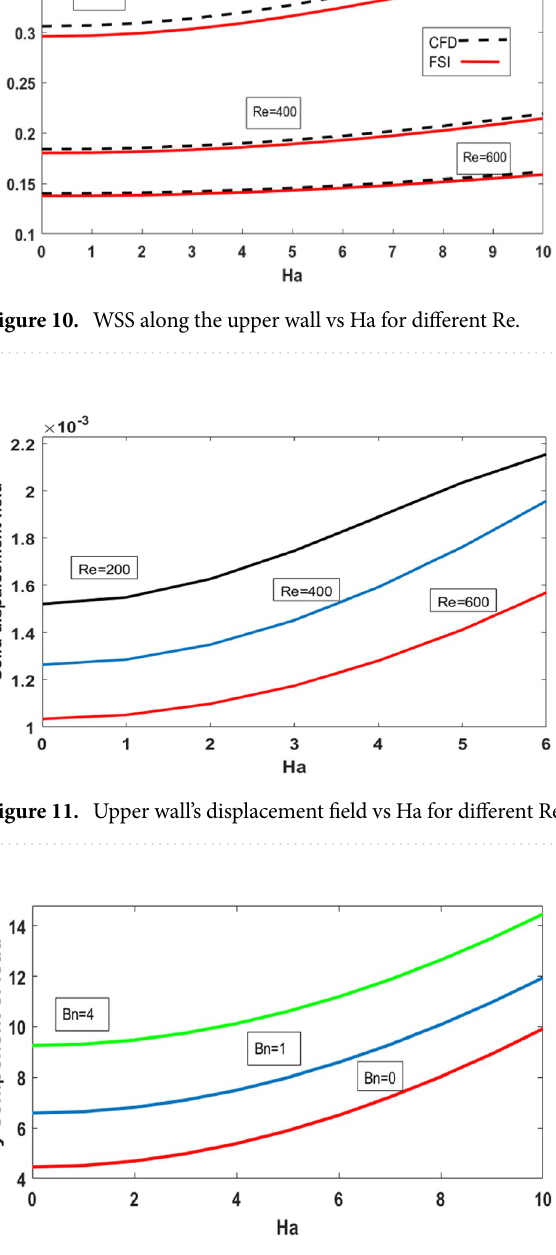
Figure 12. Fluid load on the upper wall vs Ha for different Bn.